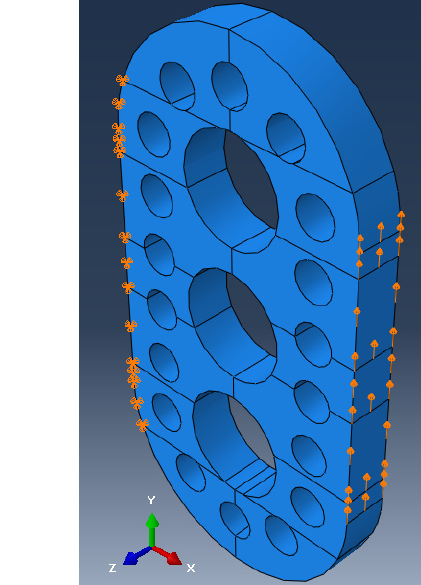
Figure 6. Sketch of Shape MYZ (total plate thickness of 1 in or 25.4 mm representing two identical ½ in or 12.7 mm plates).